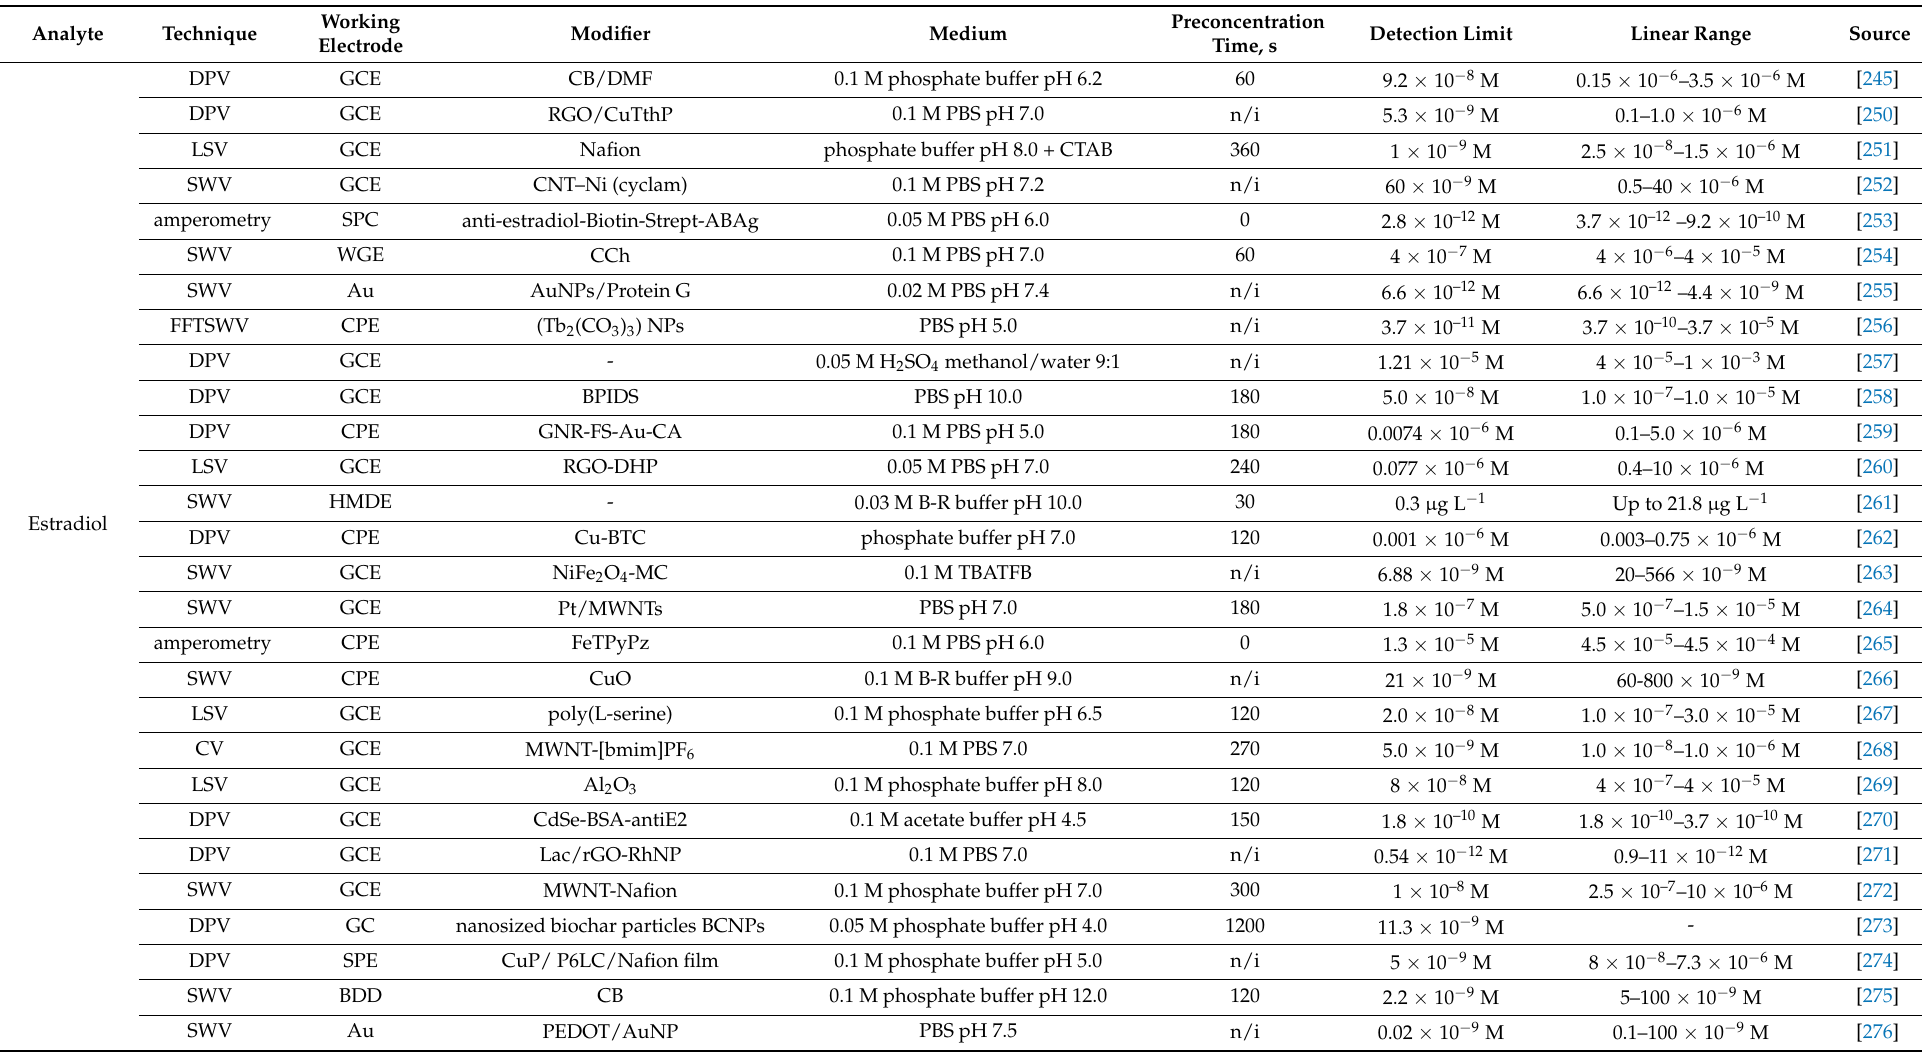
Table 5. Electrochemical methods of ovarian hormone